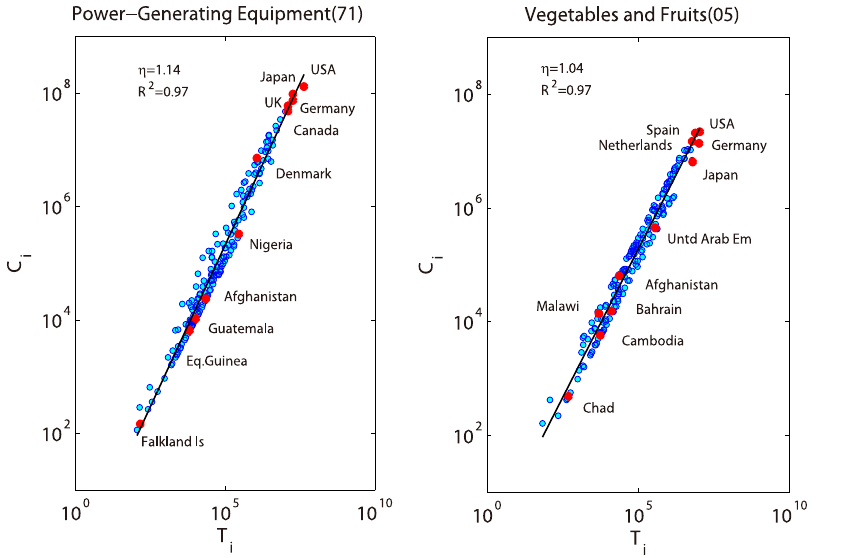
Figure 2. The allometric scaling law between T i (in U.S. dollar) and C i (in U.S. dollar) of two networks are shown. The left figure shows a super-linear scaling law (with exponent larger than 1) for power generating product, while the right one shows a sub-linear scaling law (with exponent smaller than 1) for fruit and vegetable.